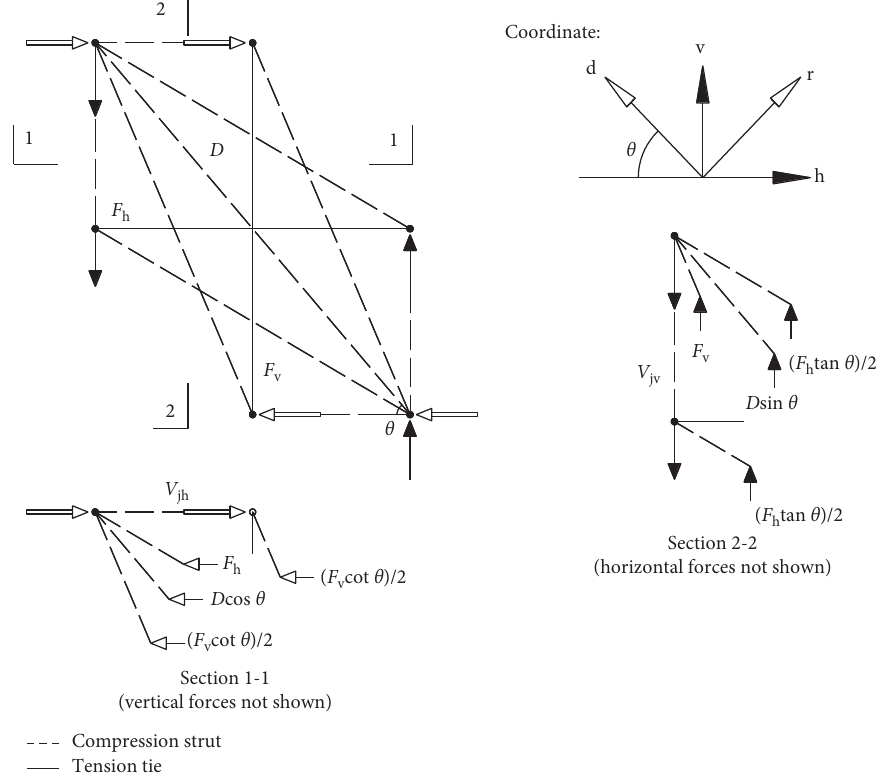
Figure 8: Strut and tie model for the web of shear